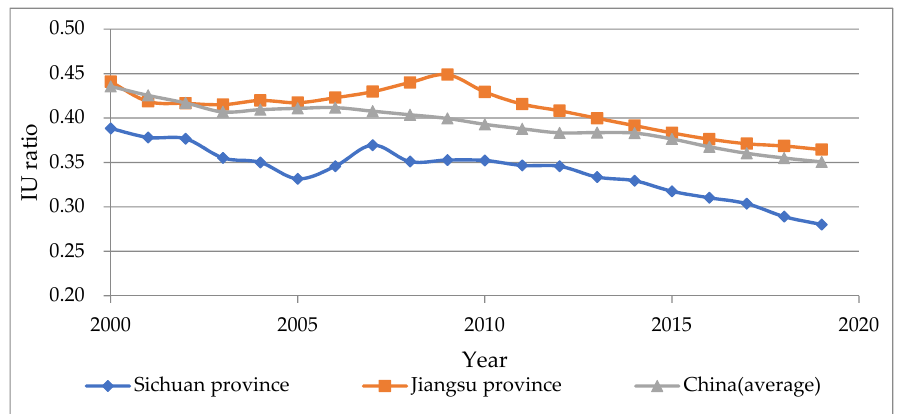
Figure 2. The calculation results and comparative analysis of IU ratio in Sichuan Province from 2000 to 2019 (data sources are Sichuan Statistical Yearbook 2020 , Jiangsu Statistical Yearbook 2020 , and China Statistical Yearbook 2020 ).